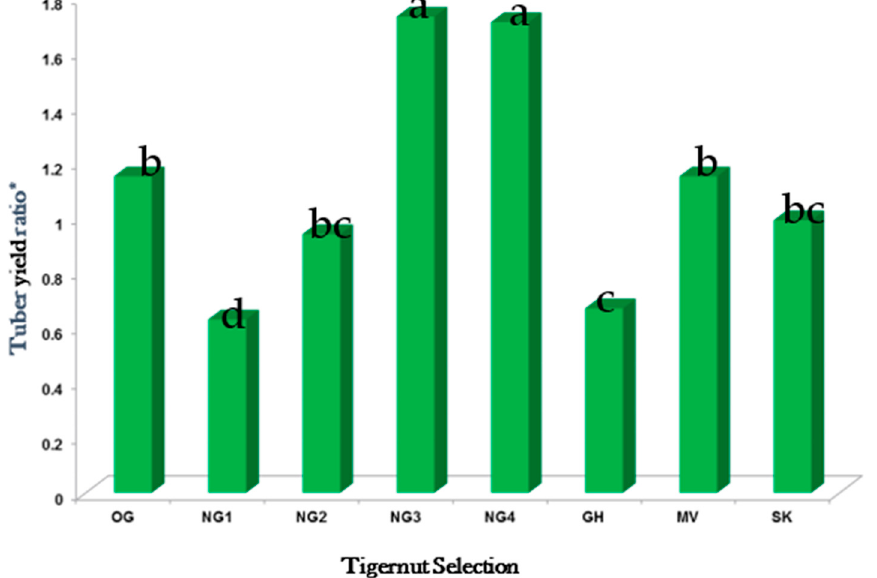
Figure 9. Combined results for tuber yield ratio in tigernut selections grown at Horticulture Farm 3, East Brunswick, Central NJ, and Rutgers Ag Research and Extension Center, Bridgeton, Southern NJ * Tuber yield ratio is the total fresh tuber weight divided by the foliage dry weight. Bars show treatment means separated by Tukey’s HSD test at a 5% significance level. Bars with similar letters are not statistically different.